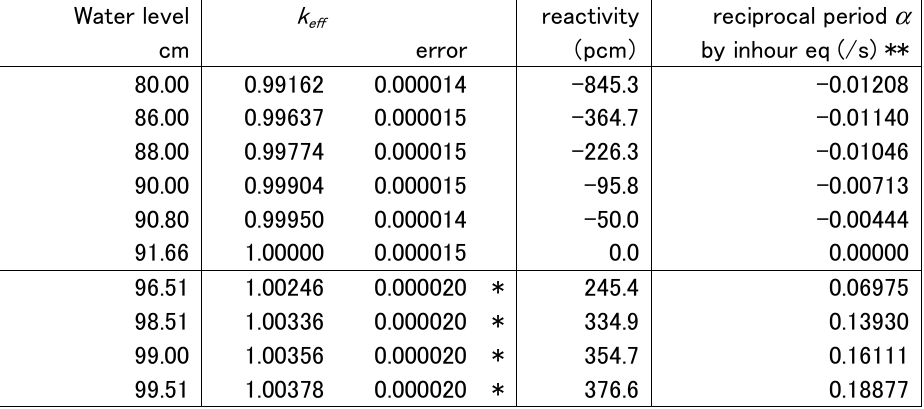
Figure 1. Geometry of the CROCUS benchmark model. Table 1. CROCUS configurations. Water levels and the corresponding